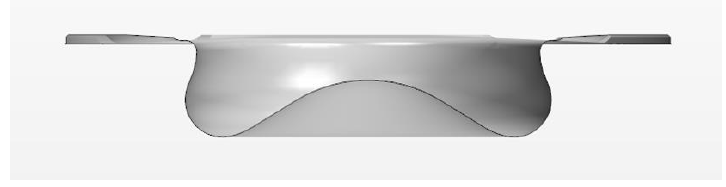
Figure 1. Re-entrant bowl design.